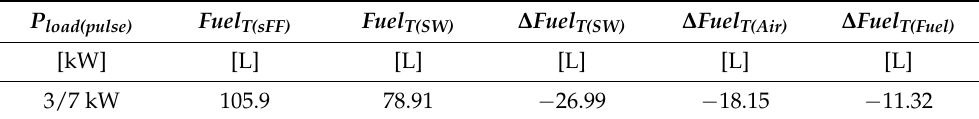
Table 5. Fuel economy for the second load profile (3/7 kW load pulses).